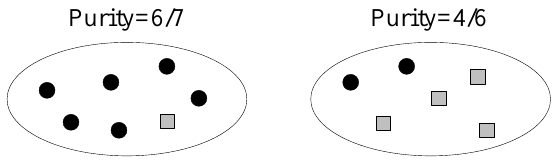
Figure 3. An example of the purity calculation. Small circles and squares are data points of different types. Data points of the same type should be clustered.